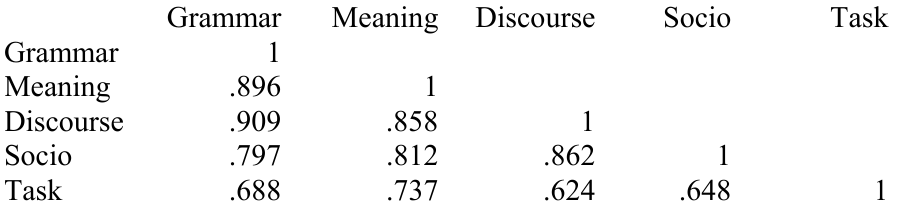
Correlation Analyses for the Intermediate Proficiency Group (N=53) Grammar